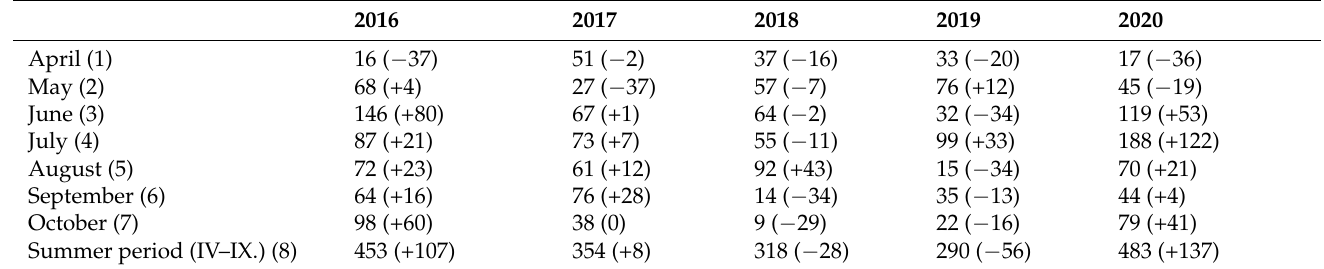
Table 4. Monthly sum of precipitation (mm) in the growing season of maize at Debrecen-L á t ó k é